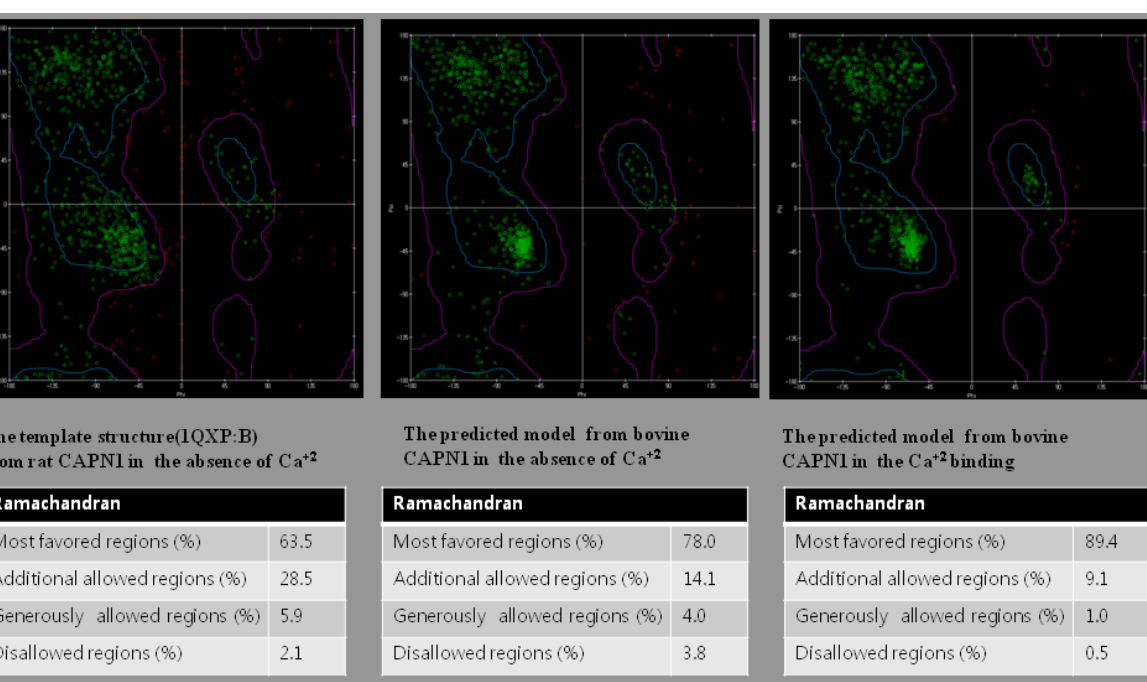
Figure 2. A structural analysis of the template structure (1QXP:B) from rat and bovine, (inactive and active) CAPN1 structural models by Ramachandran plot, a graphical representation of the local backbone conformation for phi and psi torsion angles of each residue in a protein. Amino acid types are represented graphically: glycine as triangles, proline as squares, and all other types as circles. In the side region (blue contour), acceptable regions are at least within the boundary of the overlap 10% regions on the other hand outside region (at pink contour) represent residues outside the acceptable regions outside the boundary of the overlap 10%